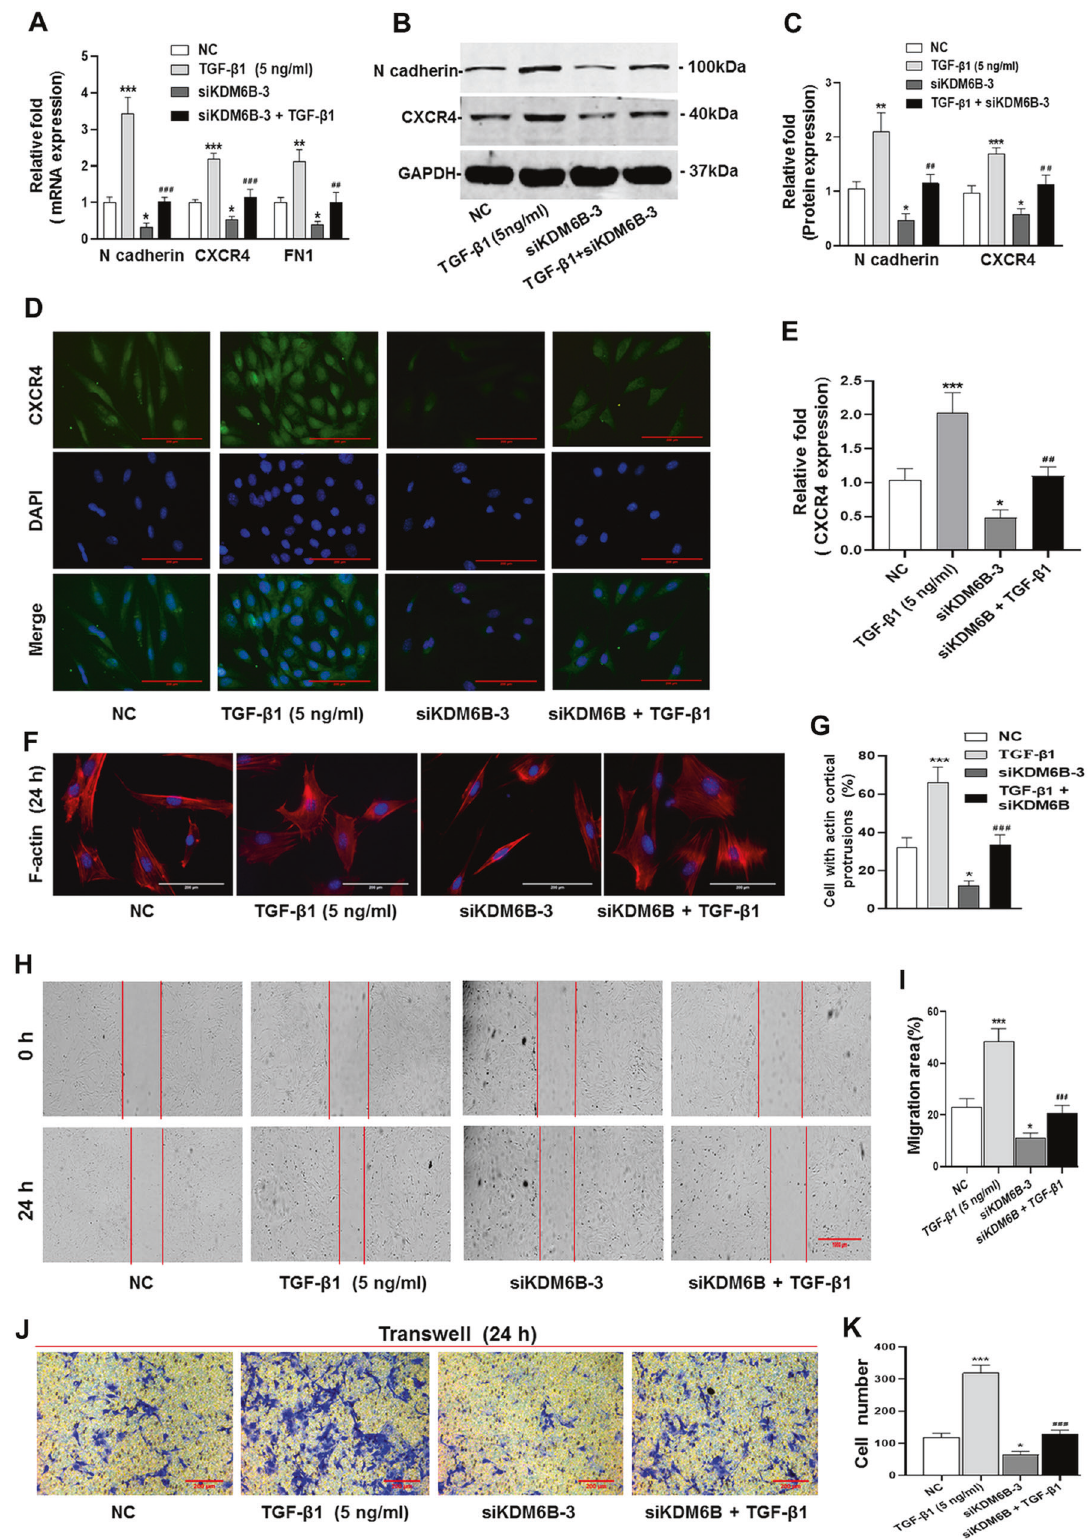
Fig. 2 Silencing of KDM6B inhibits the migration of BMSCs promoted by TGF- β 1. A – C The siRNA-KDM6B inhibited the increased mRNA and protein expression level of migration-related genes promoted by TGF - β 1. D , E The IF showed the CXCR4 expression in presence of TGF- β 1 upon siRNA-KDM6B. F , G The siRNA-KDM6B signi fi cantly inhibited the actin cortical protrusions formation promoted by TGF- β 1. H , I The scratch test showed that siRNA-KDM6B decreased the migration area of BMSCs, and also inhibited the migration area promoted by TGF- β 1. J , K Transwell test veri fi ed that siRNA-KDM6B inhibited the migrated MSCs number promoted by TGF- β 1. ( * P <0.05, ** P <0.01, *** P <0.001 in comparison with the control group; ## P <0.01, ### P <0.001 in comparison with TGF - β 1 group. All experiments were repeated three times independently. All error bars ± standard